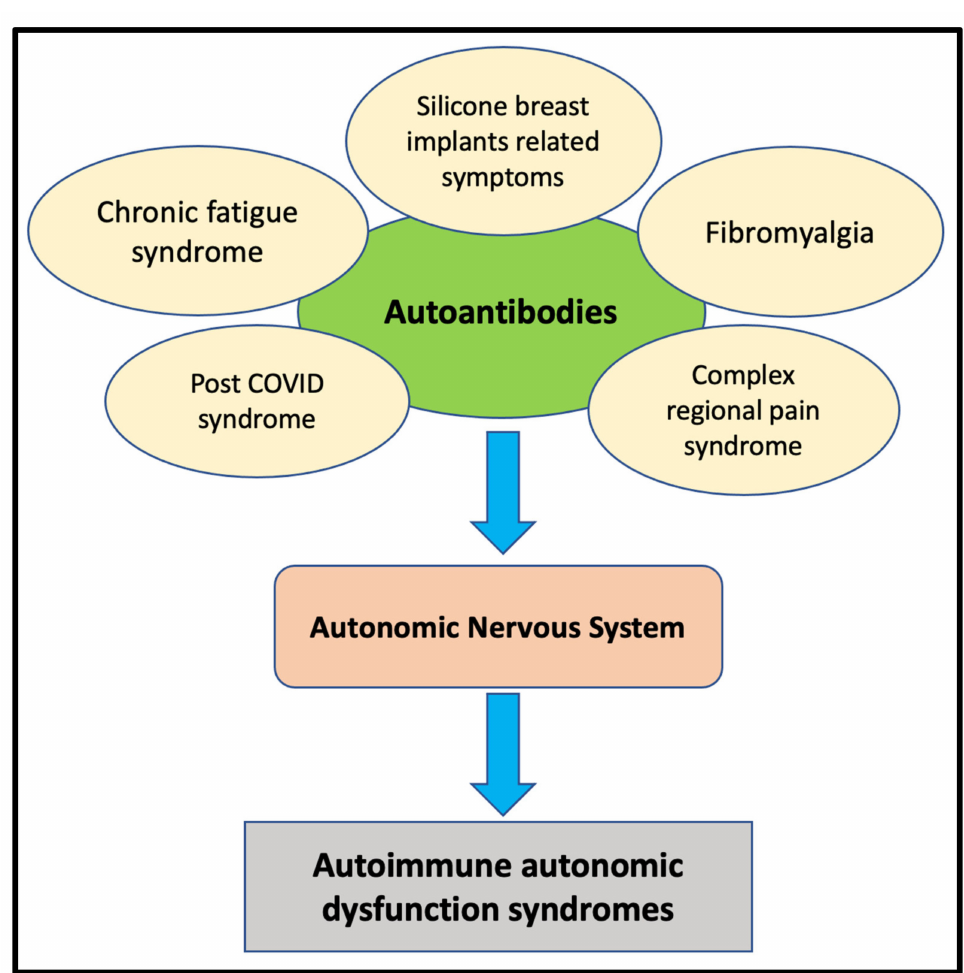
Figure 1. The presence of autoantibodies directed against the autonomic nervous system receptors and the subsequent clinical presentations of the